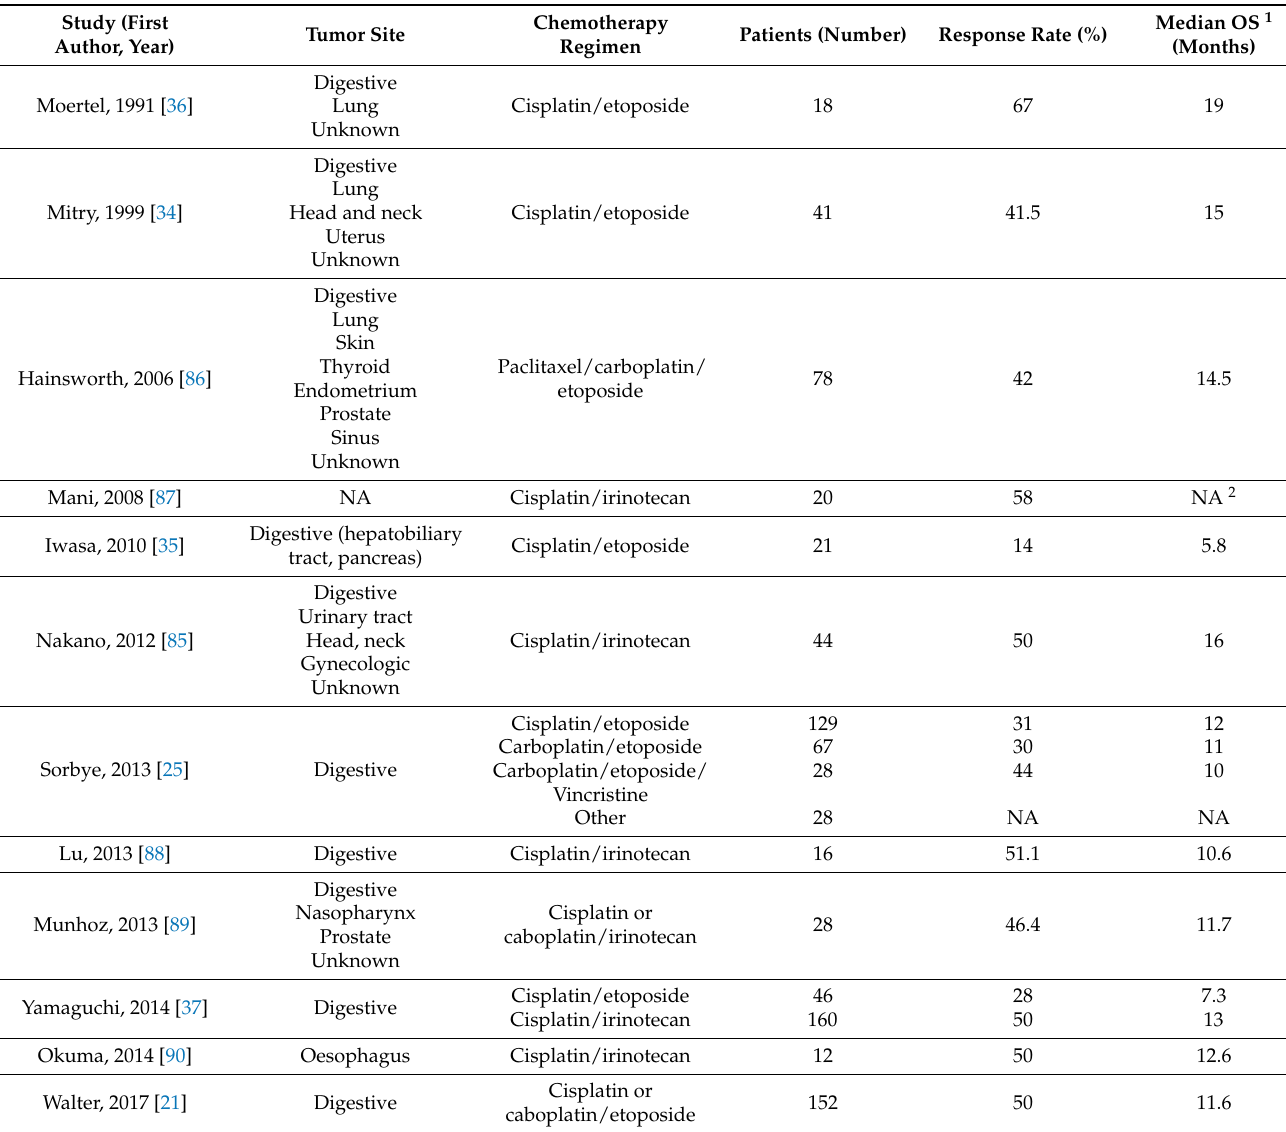
Table 2. Results of studies evaluating first-line chemotherapy in metastatic neuroendocrine carcinomas (NEC). Study (First Author,